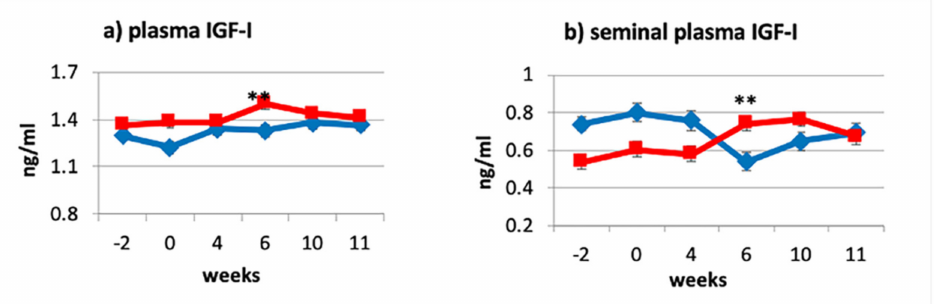
Figure 1. Effect of CLA dietary supplementation on bovine IGF-I levels in plasma ( a ) and seminal plasma ( b ) for the control (CTL (cid:7) ) and CLA ( (cid:4) ) group. Data are expressed as least square means (LSM) ± standard error (SE); ** significant levels trt × week: p ≤